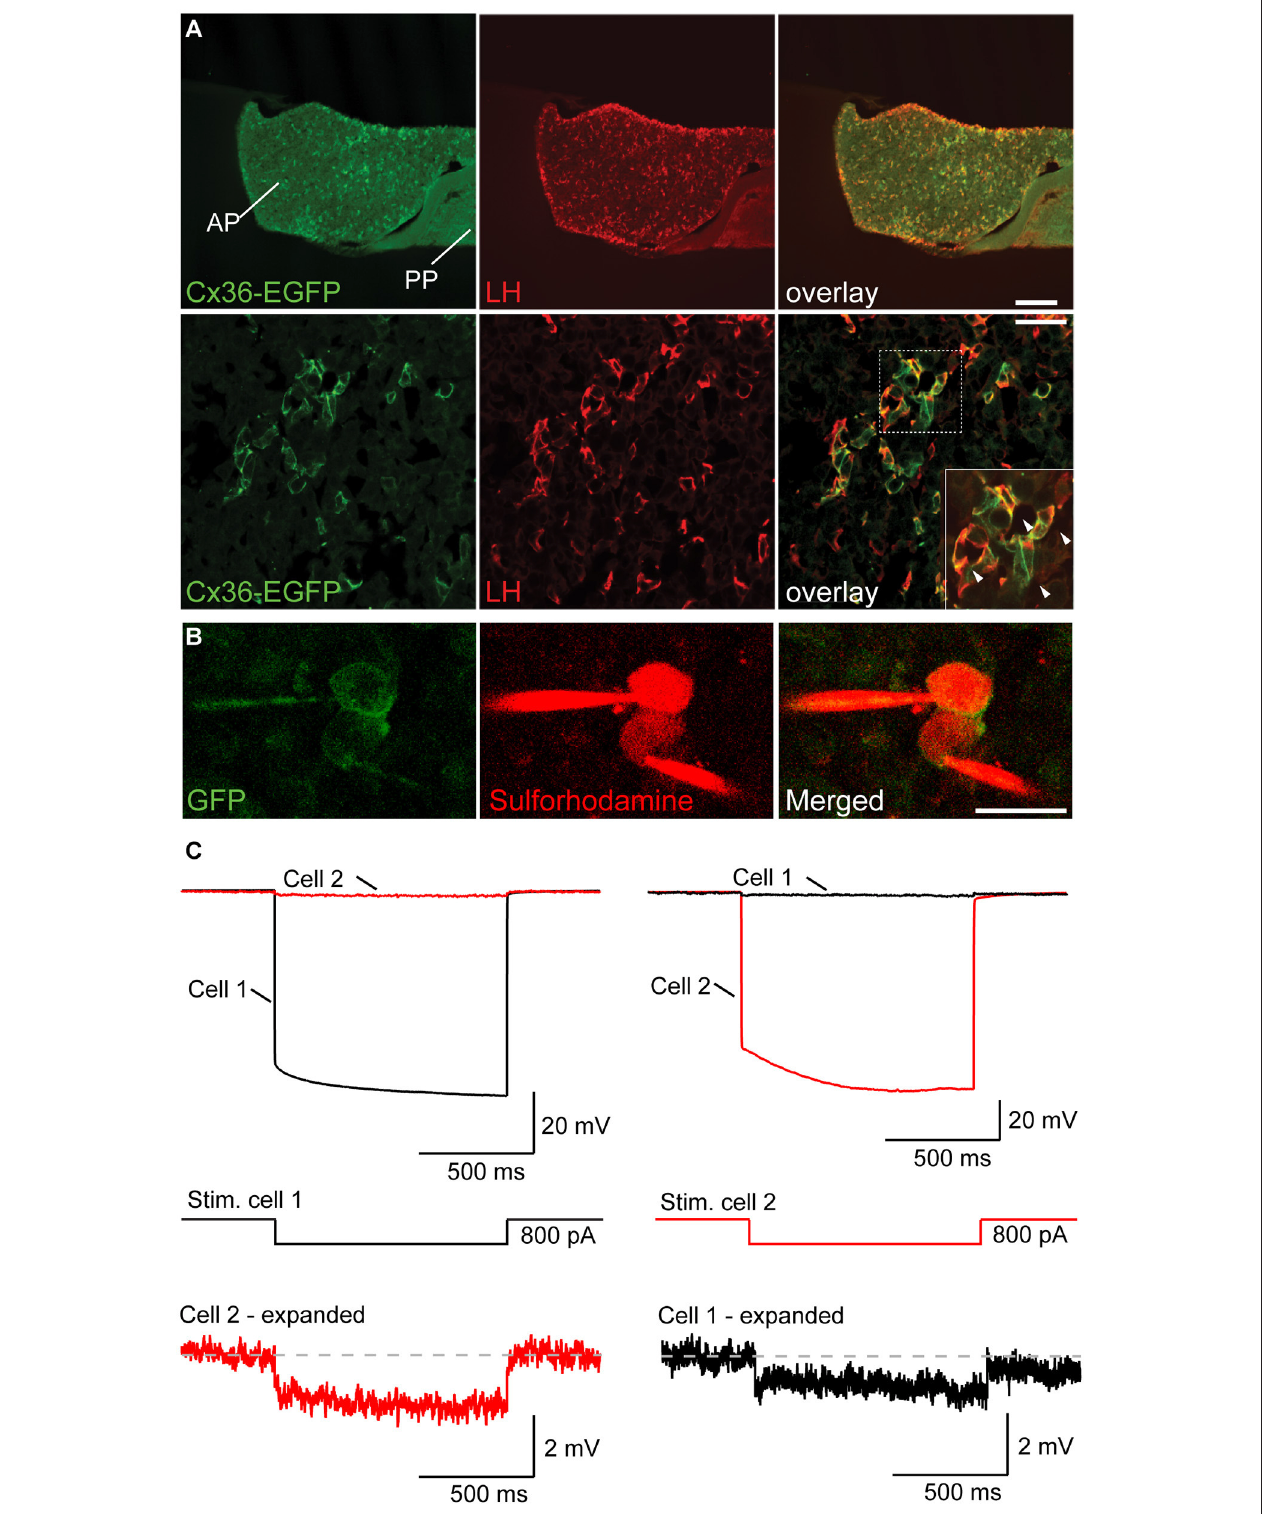
FIGURE 2 | Gonadotropes of the pituitary gland are coupled via Cx36-containing gap junctions. (A) Cx36-EGFP is expressed in LH + cells in the AP. Lower panels show higher magnification. Arrowheads in the inset highlight the localization of Cx36-EGFP signal to membrane appositions of LH + cells. AP, anterior pituitary; PP, posterior pituitary. (B) Confocal microscopy images of two adjacent EGFP + cells in the AP immediately before (left panels) and after (right panels) whole-cell